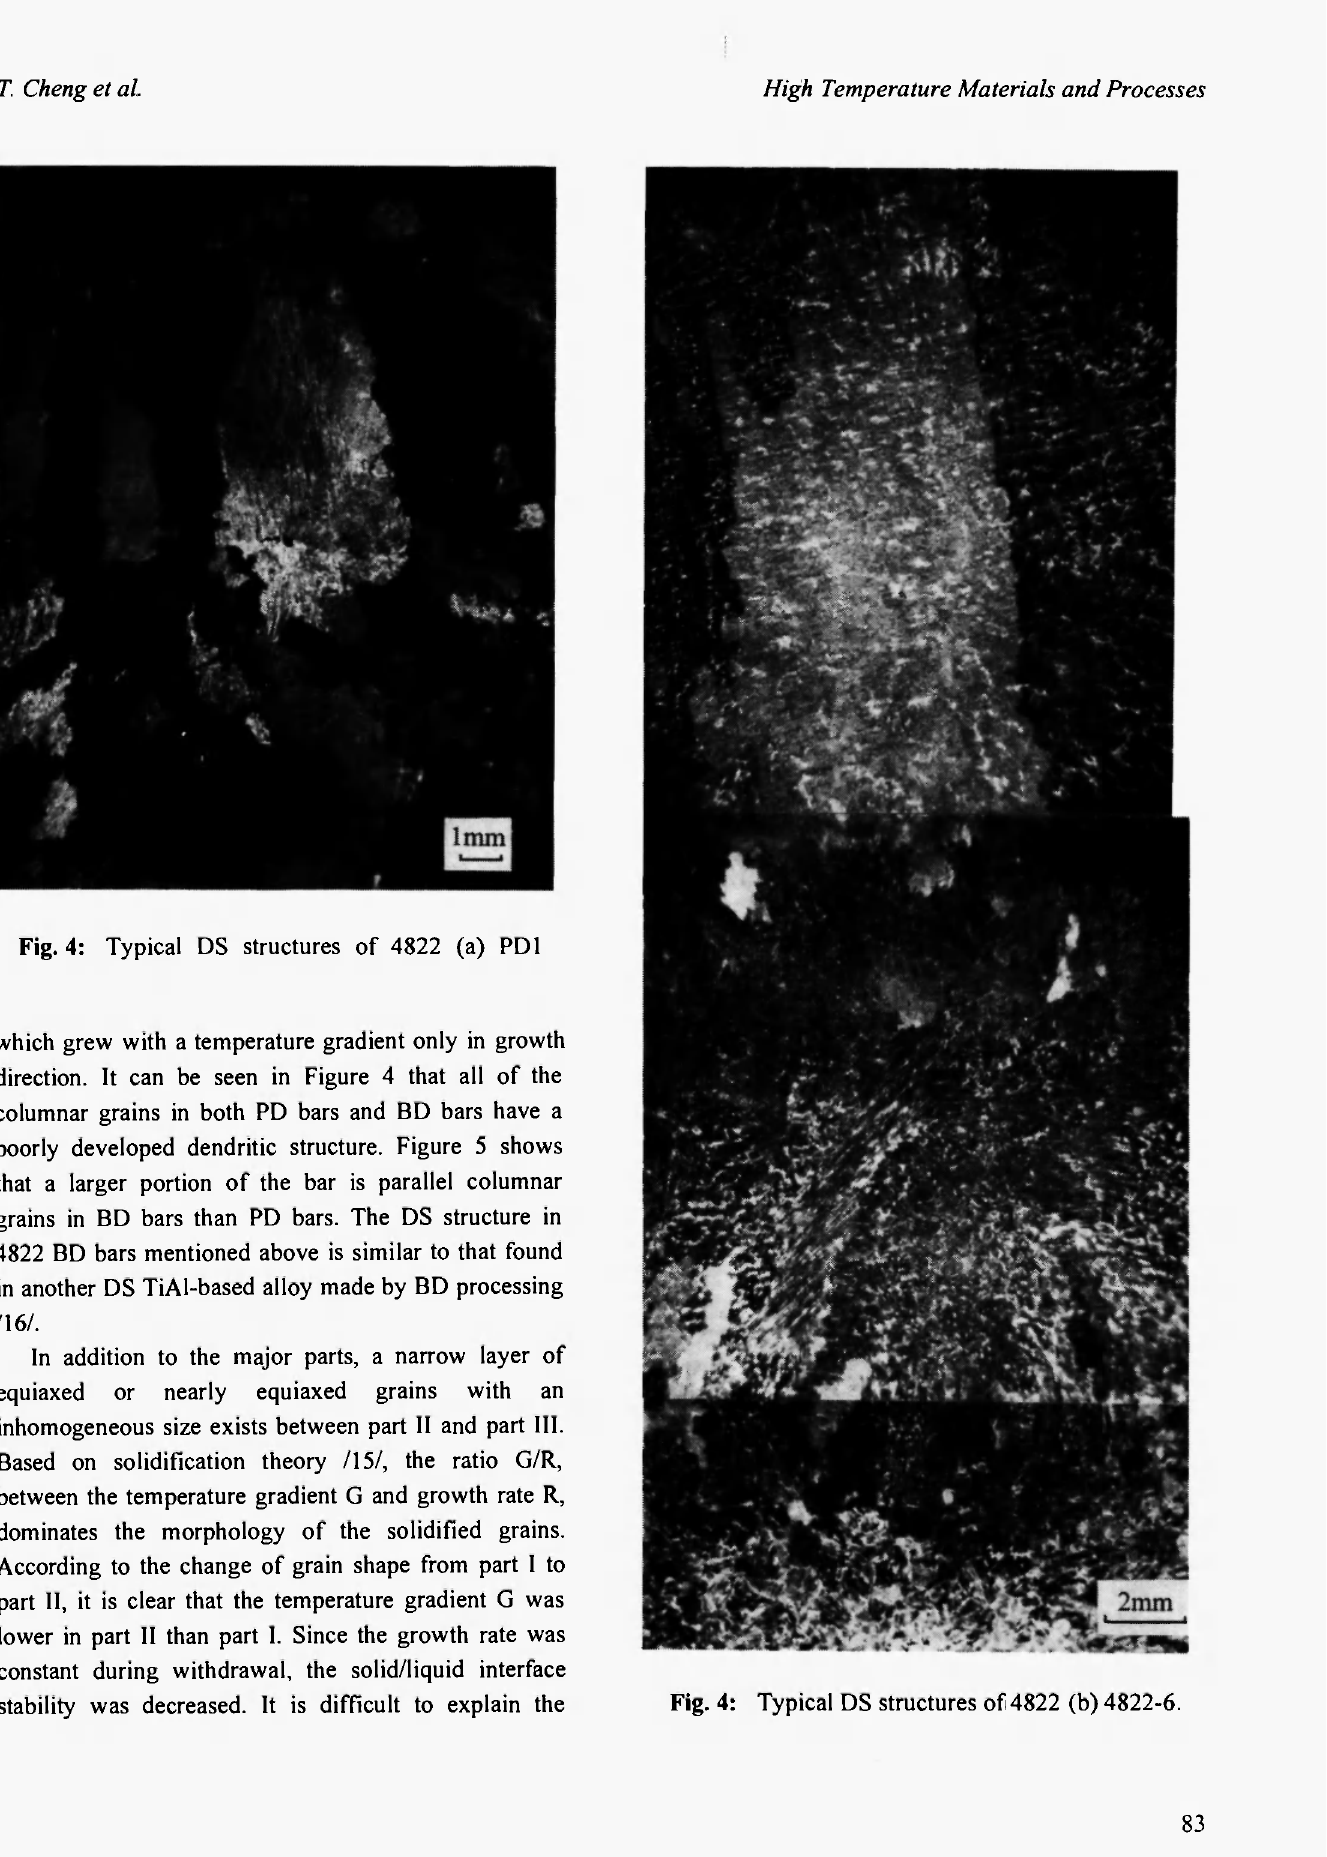
Fig. 4: Typical DS structures of 4822 (a) PD1